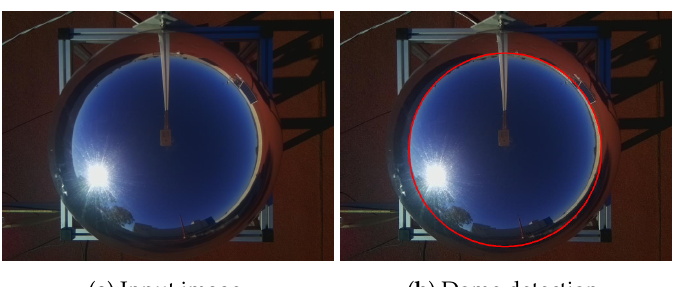
Figure 3. Dome detection example. The input color image, as well as the dome detection are shown in ( a , b ), respectively.